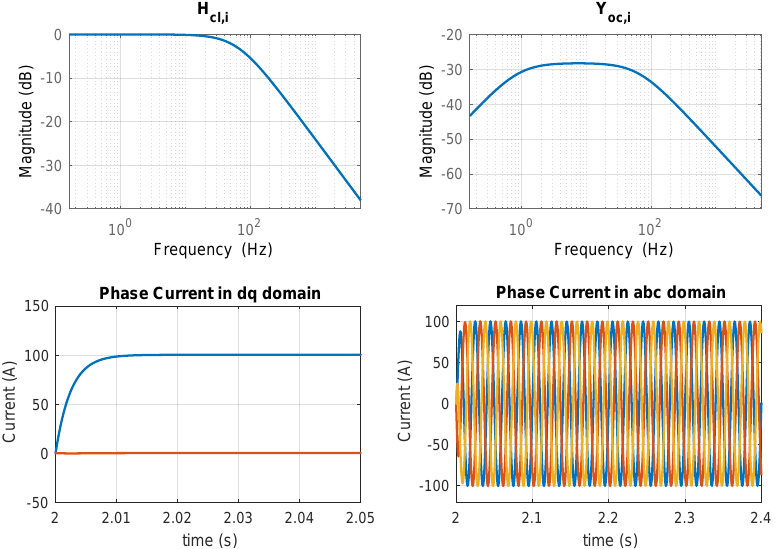
Figure 6. ( Top left ) Frequency response of closed-loop output to reference transfer function; ( Top right ) frequency response of output admittance with current control (base case); ( Bottom left ) time response of phase currents in the dq domain; ( Bottom right ) time response plot of phase currents in the abc domain for a step change to validate base